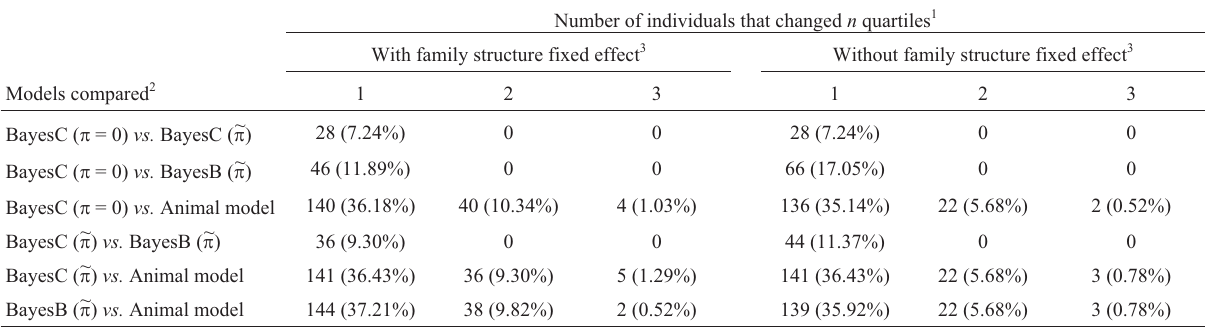
Table 2 - Comparison of the number and percentage of individuals with estimated breeding values for Warner-Bratzler shear force that changed n quartiles between any two analyses.